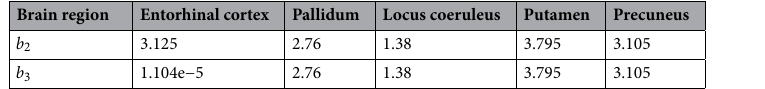
Table 4. Modified b 2 and b 3 values.